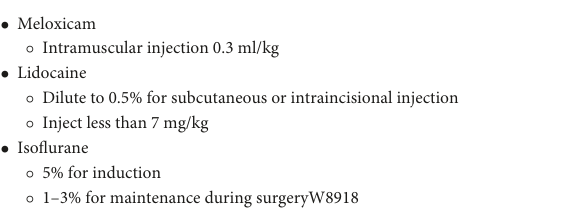
layers of spray rubber (Plasti Dip R (cid:13) ) and both of the fibers were joined with a carbon epoxy (Atom Adhesives, Fort Lauderdale, FL, USA, #AA-CARB61), which conducts electricity between fibers. The final diameter of the cortical fiber was an average of 0.64 mm ( Supplementary Figure 2 ). Finally, the resistance of the electrodes was measured with a voltmeter and marked with a range of 2–8 k ω